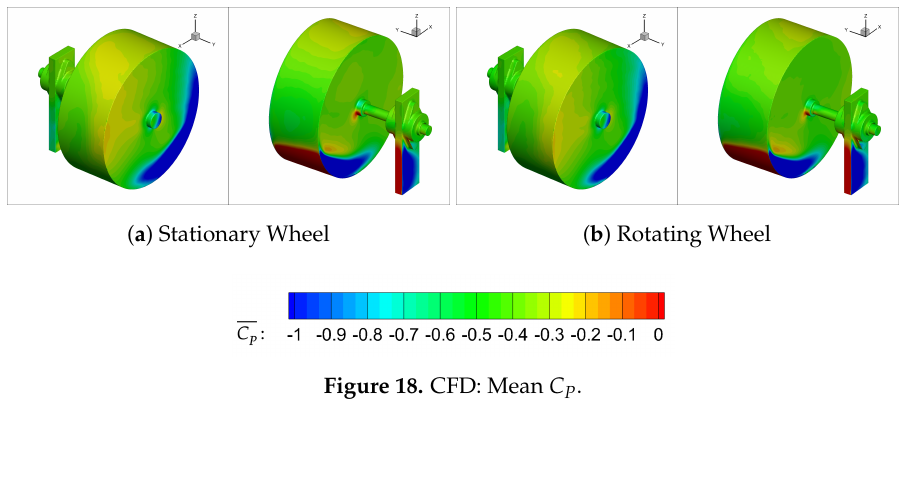
Figure 18. CFD: Mean C P